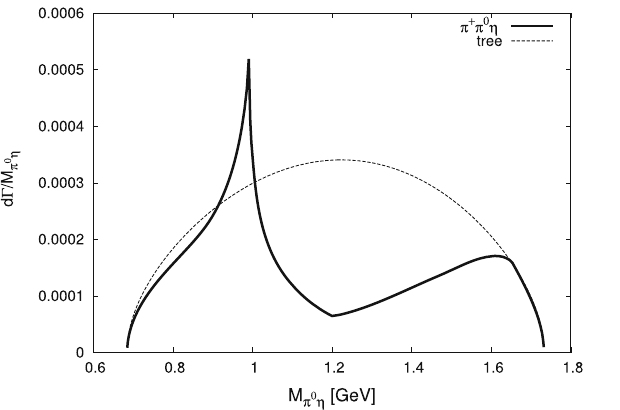
Fig. 9 Differential cross sections for D + → π + π 0 η (solid lines) and D + → π + ηη (dashed lines). The labels (a), (b), (c) stand for the sets of parameters of Eq. (32)